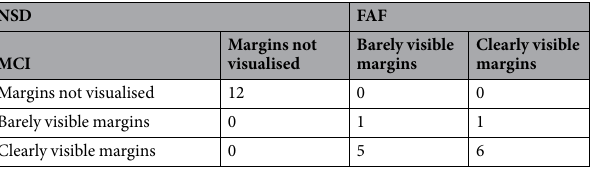
Table 2. Comparison of definition (distinctness) of neurosensory detachment (NSD) on multicolour imaging (MCI) and fundus autofluorescence (FAF). In 19/25 (76%) eyes, the grading was consistent while in six eyes there was a discrepancy with five eyes favouring